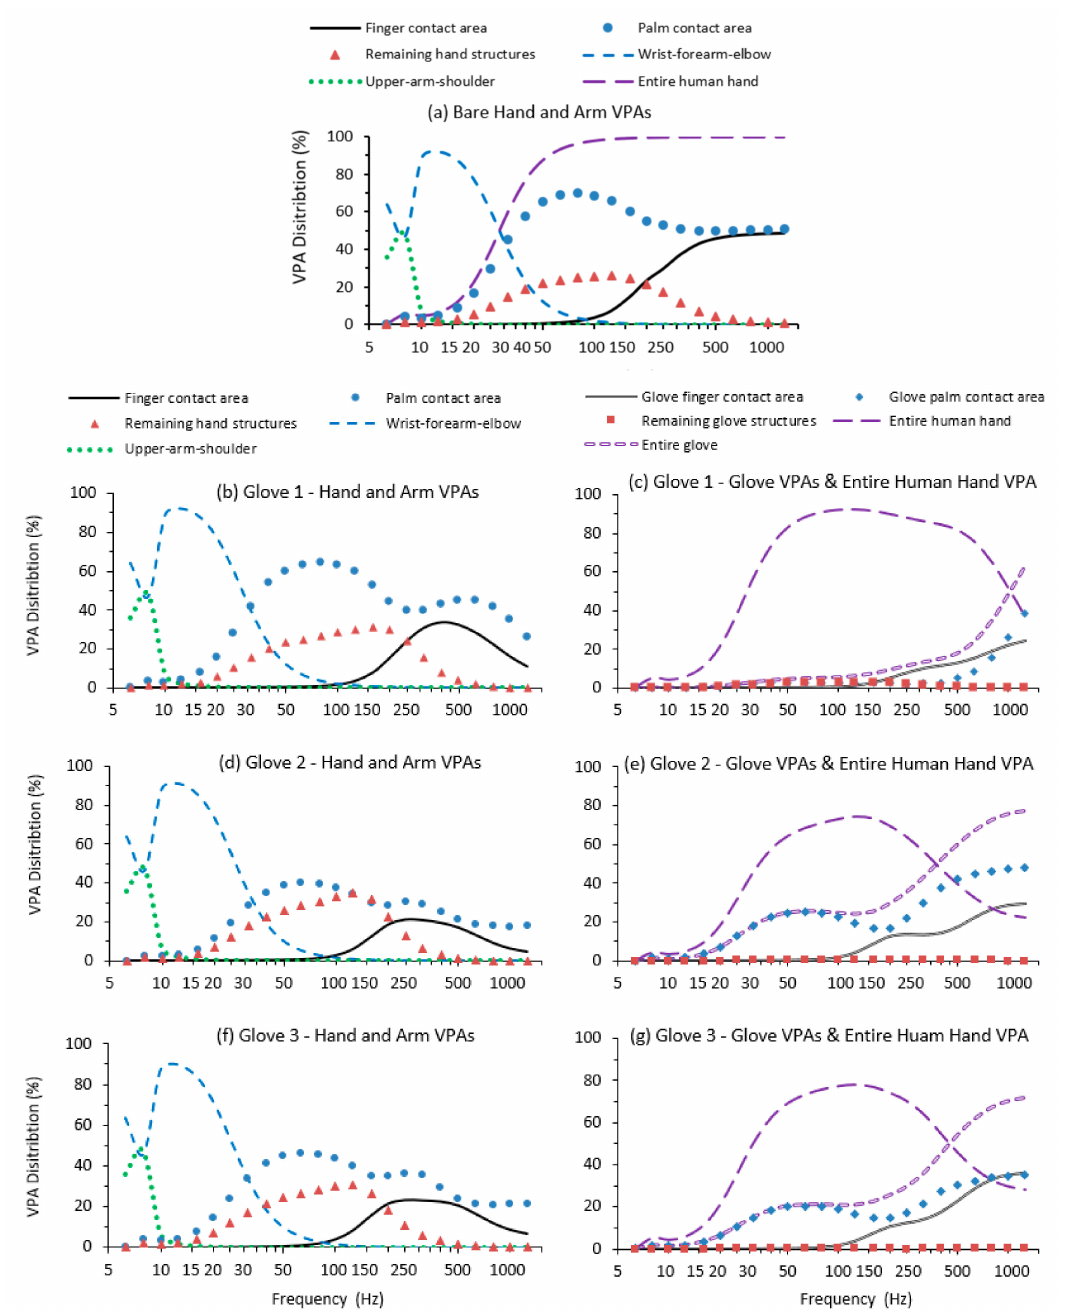
Figure 2. Percent distributions of the vibration power absorption in the substructures of the glove–hand–arm system calculated using Equation (23): ( a ) bare hand and arm VPAs; ( b ) hand and arm VPAs with Glove 1; ( c ) Glove VPAs and entire hand VPA with Glove 1; ( d ) hand and arm VPAs with Glove 2; ( e ) Glove VPAs and entire hand VPA with Glove 2; ( f ) hand and arm VPAs with Glove 3; and ( g ) Glove VPAs and entire hand VPA with Glove